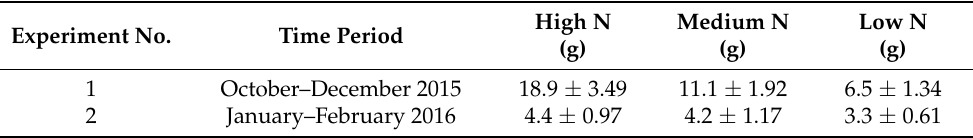
Table 6. The mean total biomass increases with nitrogen rate increase for the two experiments conducted in the greenhouse. Experiment